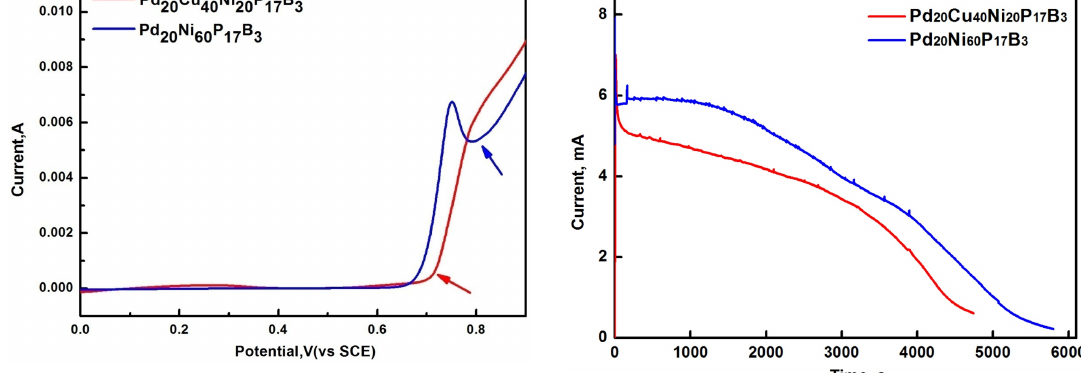
Figure 1. polarization curves of the Pd metallic glasses, measured in 0.8 mol·L –1 H H PO solutions (vs SCE). 3 4